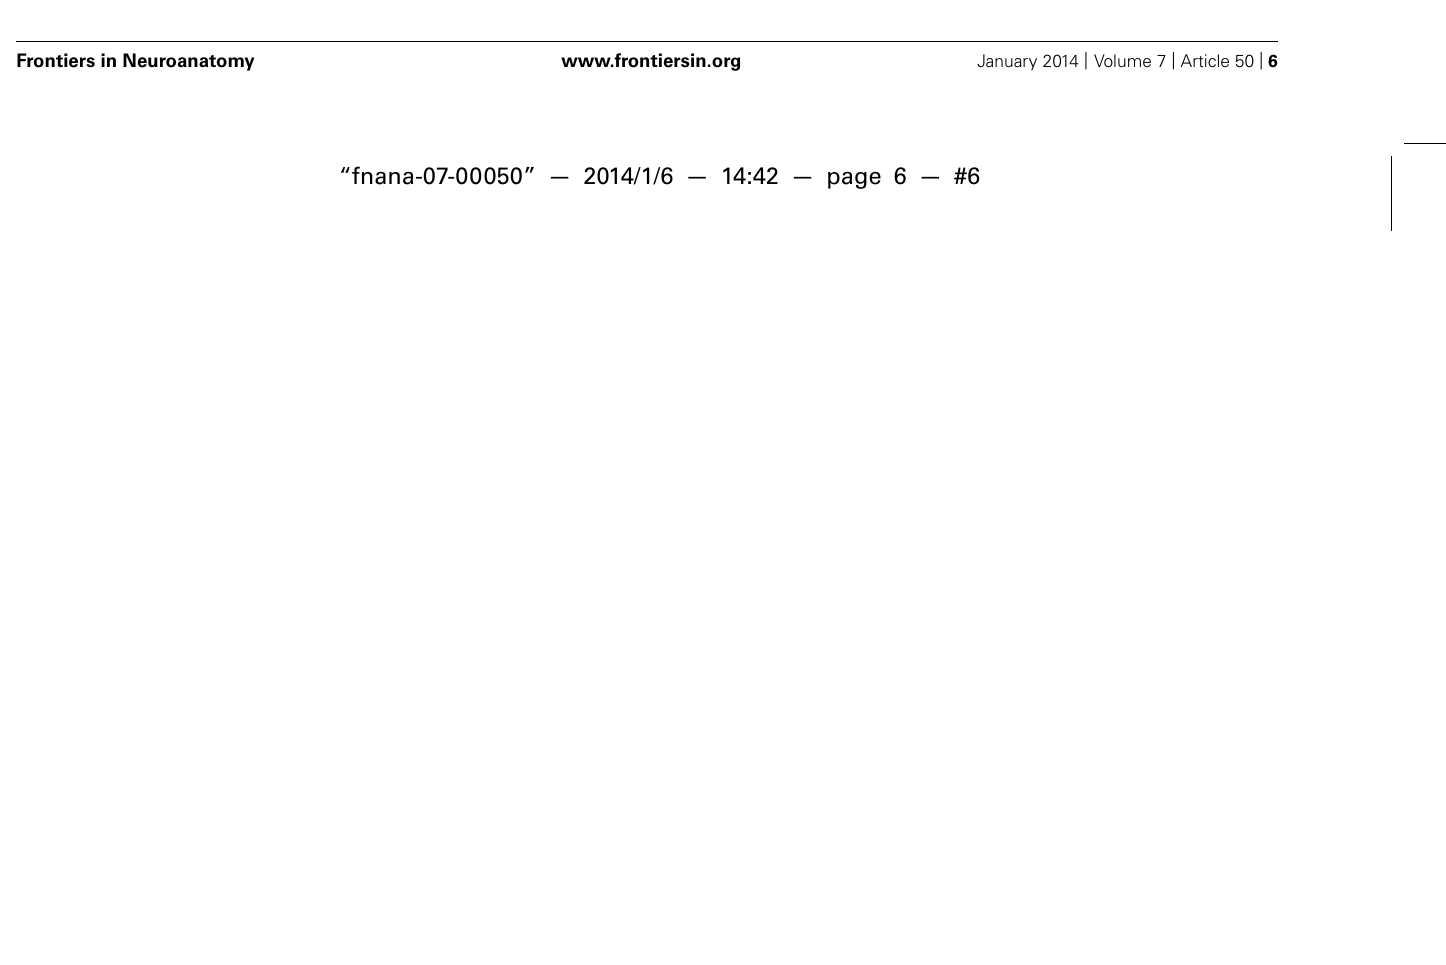
in the IGL, labels mossy fiber presynaptic terminals. Overlay (ovl) in ( C,F,I) . In high magnifications (G – I) note EGFP + terminal (arrowhead in H ) and faintly labeled distal axon (arrow in H ). Scale bar: (A – C) 75 μ m; (D – F) 25 μ m; (G – I) 10 μ